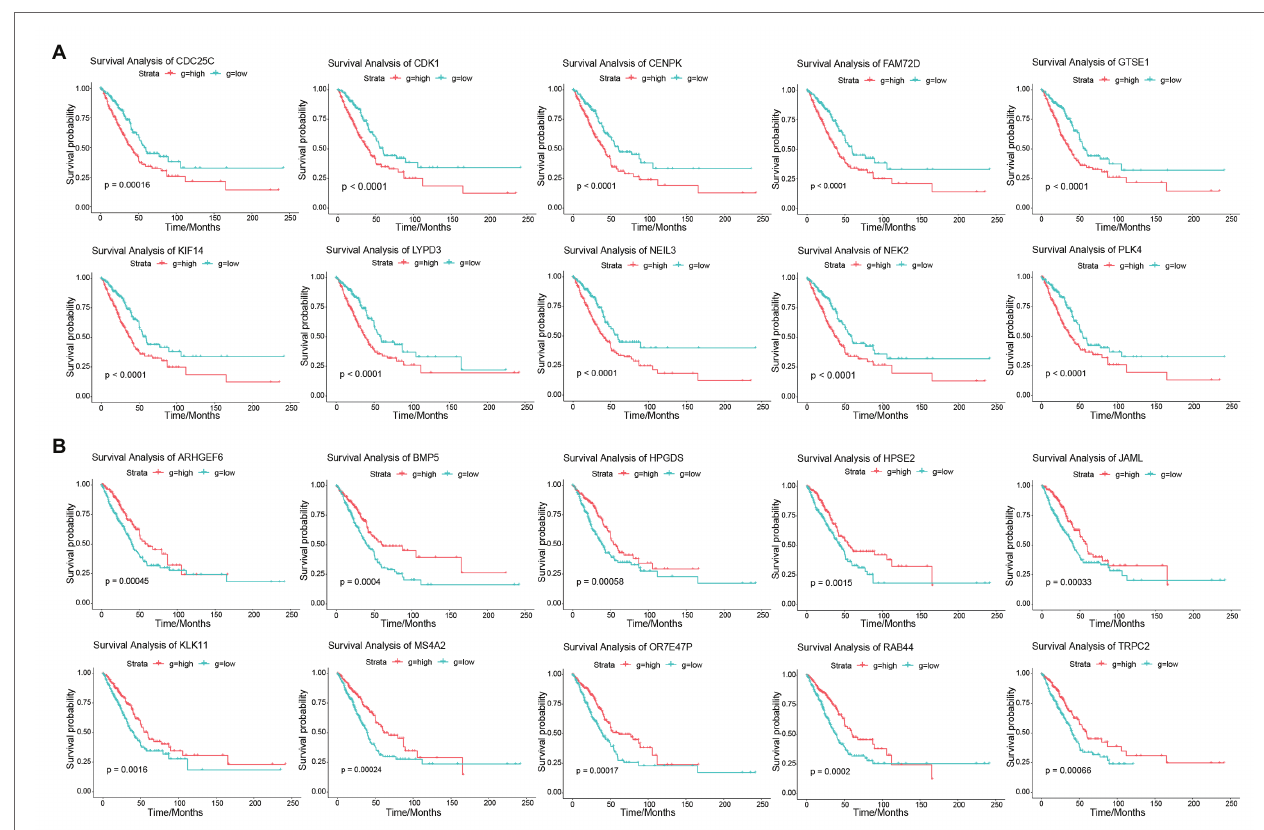
FIGURE 3 | Survival analysis. (A) Survival curves of 10 genes most significantly correlated with LUAD in LUAD-unfavorable gene set. (B) Survival curves of 10 genes most significantly correlated with LUAD in LUAD-favorable gene